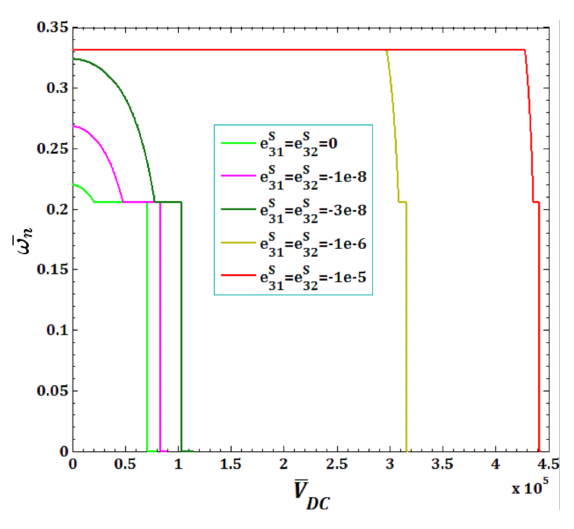
Figure 10: The effects of surface/interface residual stress for pull- in voltage on DNF of SS FC-MWPENS.